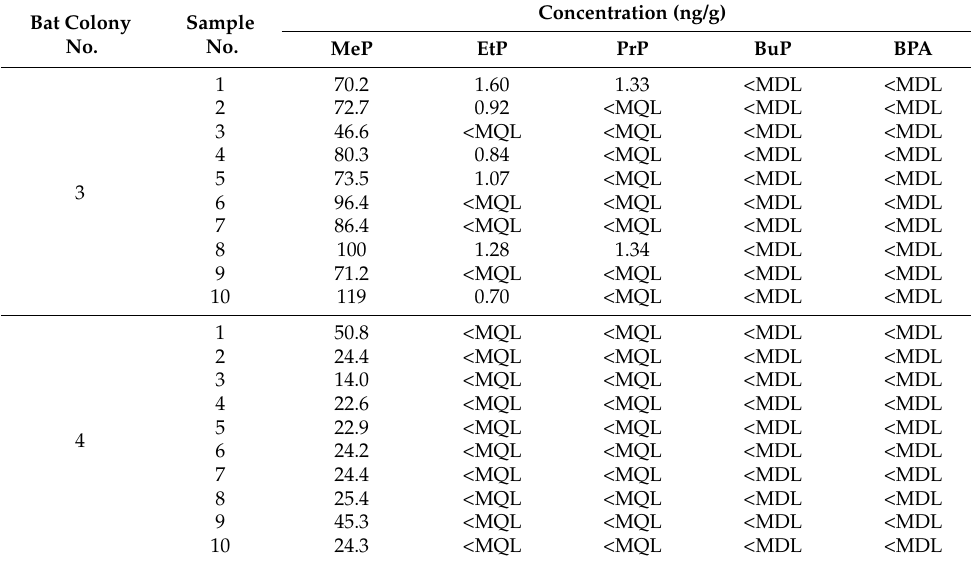
Table 2. Cont. Bat Colony No.